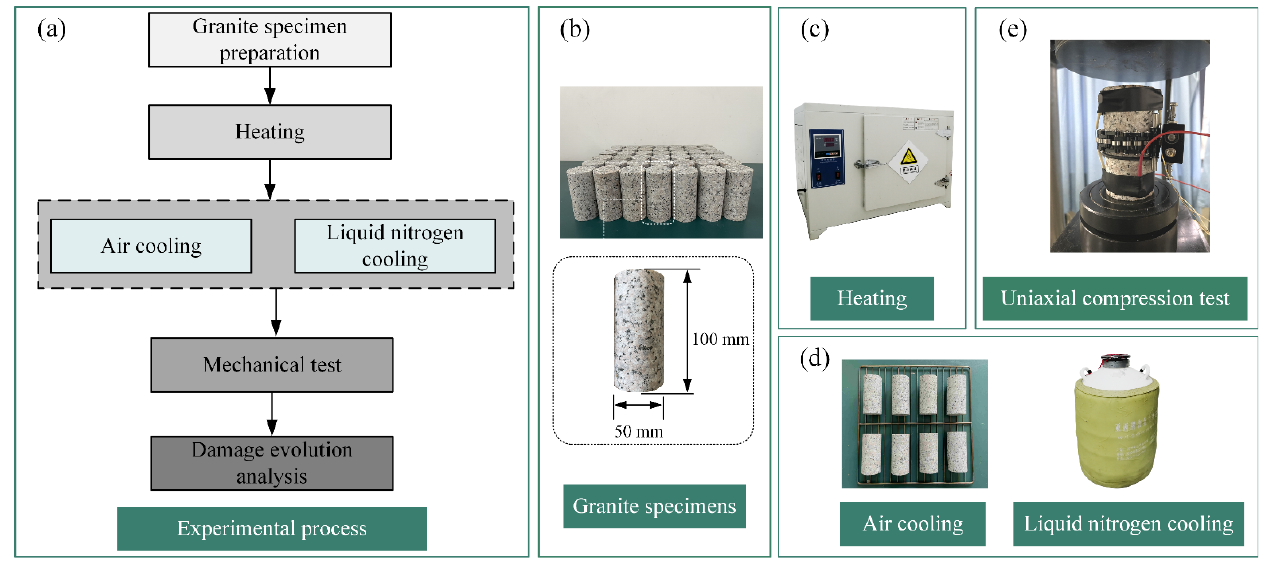
Figure 1. Experimental procedure.